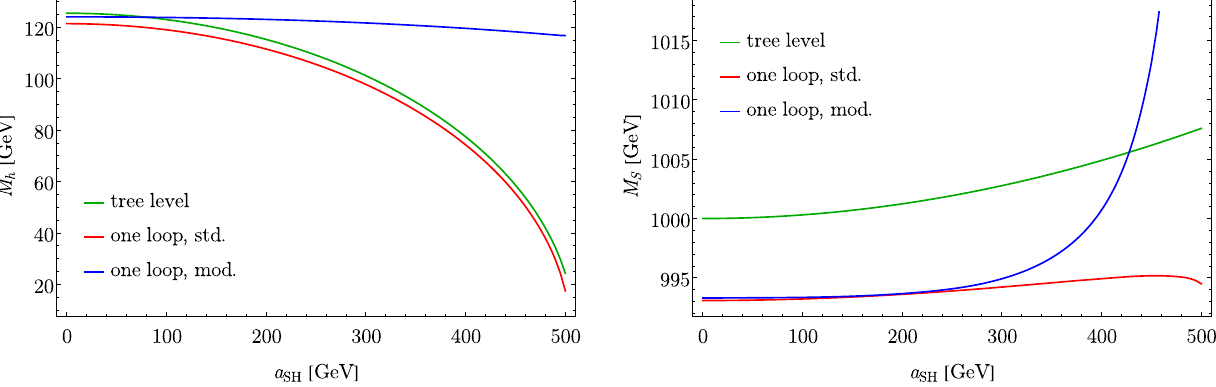
= 0 GeV, λ = 0 . 52, λ S